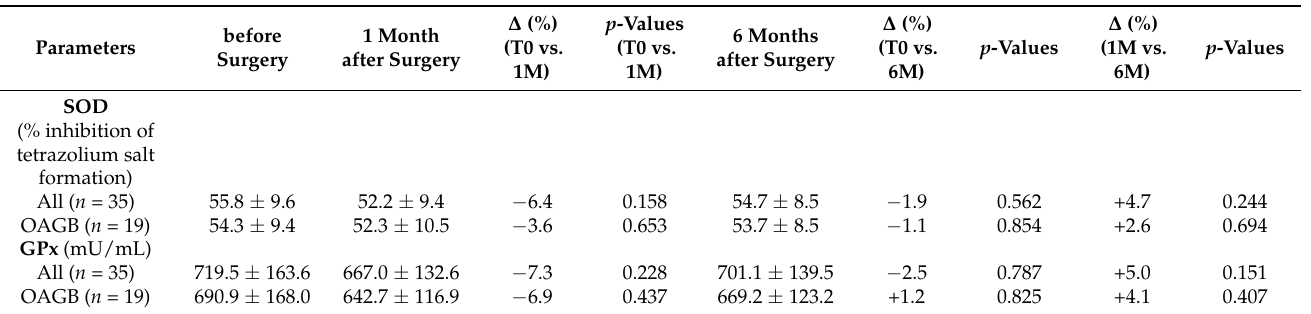
Table 2. Alterations of the activities of antioxidant enzymes in patients ( n = 35) undergoing bariatric surgery 1 .